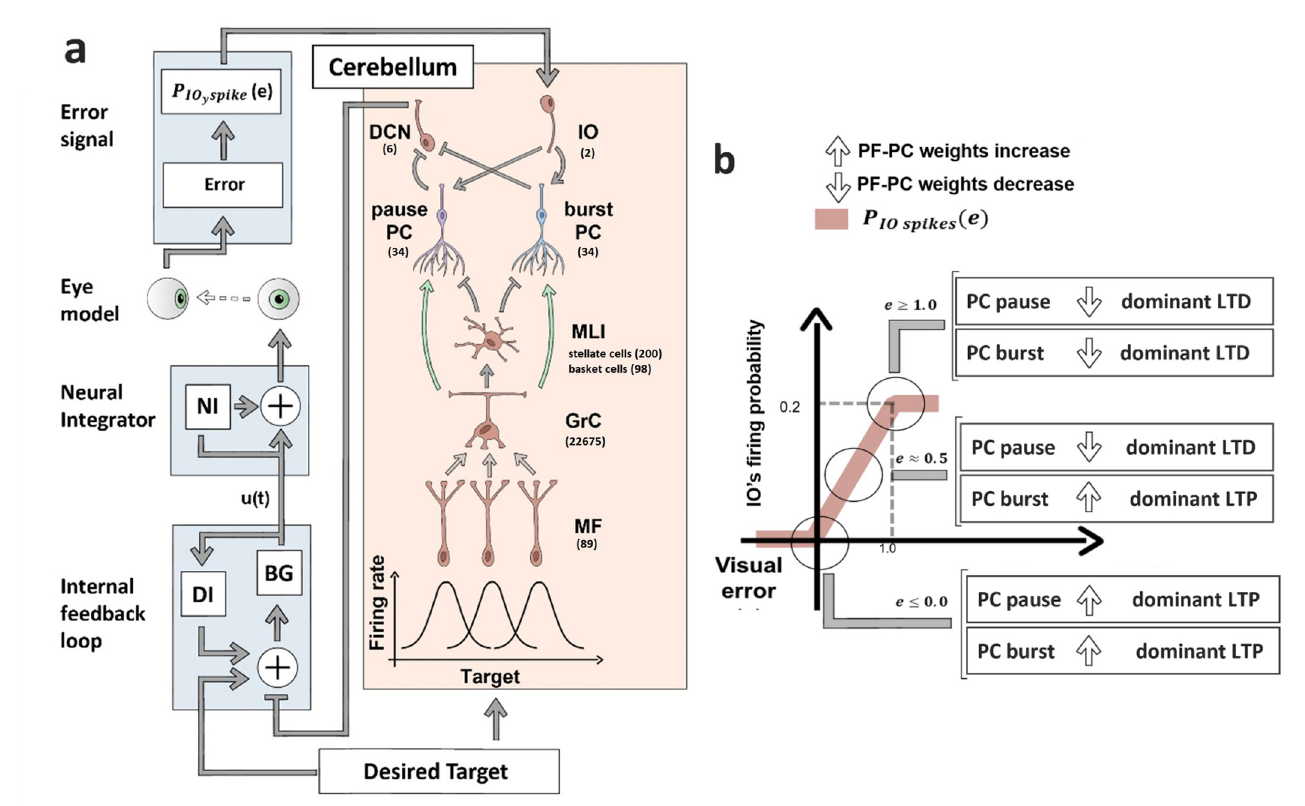
Fig 1. Schematic of the control loop. a) The target displacement information (desired target) is sent to the internal feedback loop (IFL) and to the cerebellum. In the cerebellum, the target displacement is encoded by the gaussian receptive field of the Mossy fibers (MF), MF are connected to the granule cells (GrC), which, through their axonal endings (namely the parallel fibers (PFs)) excite both the Purkinje cells (PC), and the molecular layer interneurons (MLI), composed of basket and stellate cells. The connection between PF and PC is the only plastic one in the model (represented by the green arrows). The MLI are connected to the PCs. The PCs are split in two subpopulations: pause PC and burst PC (light blue). PCs are connected to the deep cerebellar nuclei (DCN), which are the output of the cerebellum and project to the IFL. The IFL is composed by the Displacement integrator (DI) and the Burst generator (BG), and sends signals to the neural integrator (NI). The IFL generates speed command (u(t)) to be followed by the eye, while the NI transforms this speed command into motor torques by means of pulse-step integration. If the resulting movement is erroneous, then the error information is encoded by the firing rate of the inferior olive (IO), which projects onto to the PCs. b) Relation between the foveal error (e) and the IO firing probability (PIO spikes). The effect of different PIO spike on the PF-PC weight changes are shown for 3 scenarios for the foveal error: error < = 0, error = 0.5 and error > = 1. For each error range, the effect of the related IO’s firing probability (producing an LTD in PF-PC synapses), and the error-independent LTP on the two PC subpopulations is showed. If the arrow points down the overall PF-PC weight decreases due to dominant LTD process, decreasing the firing rate of the PCs on subsequent trials, if the arrow points up then the resulting weight change is positive due to dominant LTP process, increasing the PC firing rate on subsequent